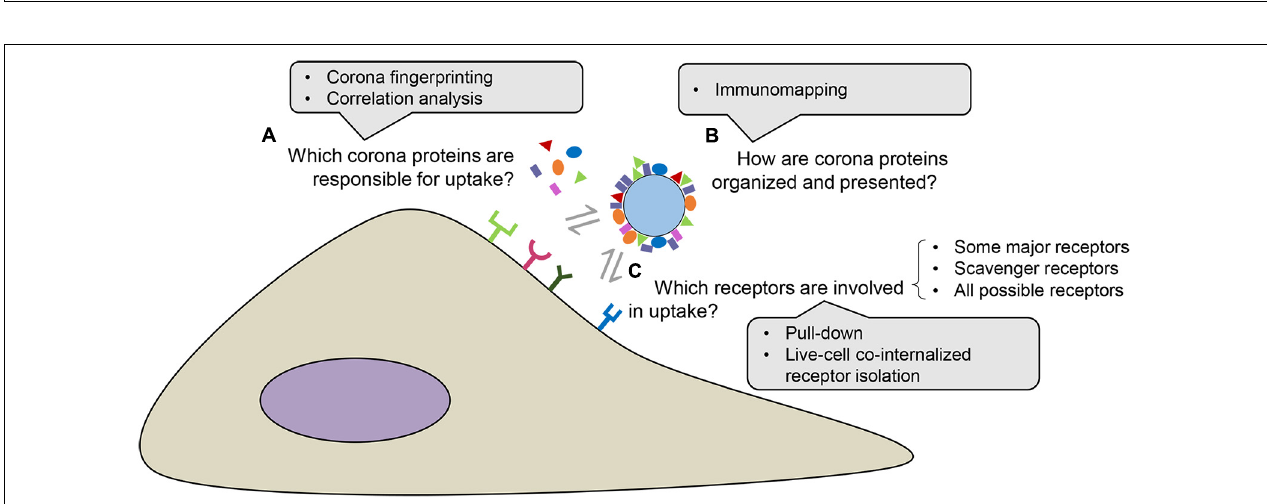
FIGURE 2 | Methods to elucidate nanoparticle protein corona-receptor interactions. First, corona proteins involved in nanoparticle uptake can be identified by associating the corona composition and nanoparticle uptake efficiency, for instance by using corona fingerprinting or correlation analysis (A) (Walkey et al., 2014; Liu et al., 2015; Ritz et al., 2015). The distribution of corona proteins and how their epitopes are presented can be determined by immunomapping-based techniques (B) (Kelly et al., 2015). Finally, receptors involved in the uptake of nanoparticle-corona complexes can be deduced from the corona composition or can be directly identified using pull-down or live-cell co-internalized receptor isolation approaches (C) (Bewersdorff et al., 2017; Ito et al., 2020; Aliyandi et al., unpublished).